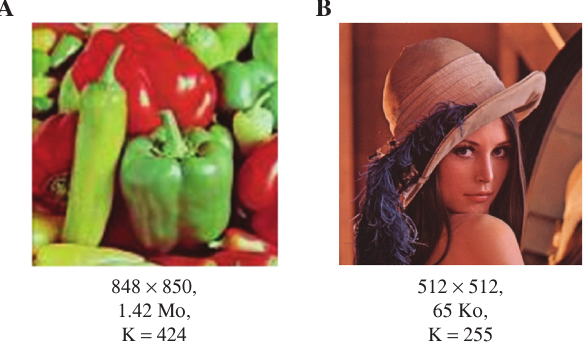
Figure 10: Images used for Proposed Algorithm. Images used: (A) pepper.jpg and (B) lena.jpg.